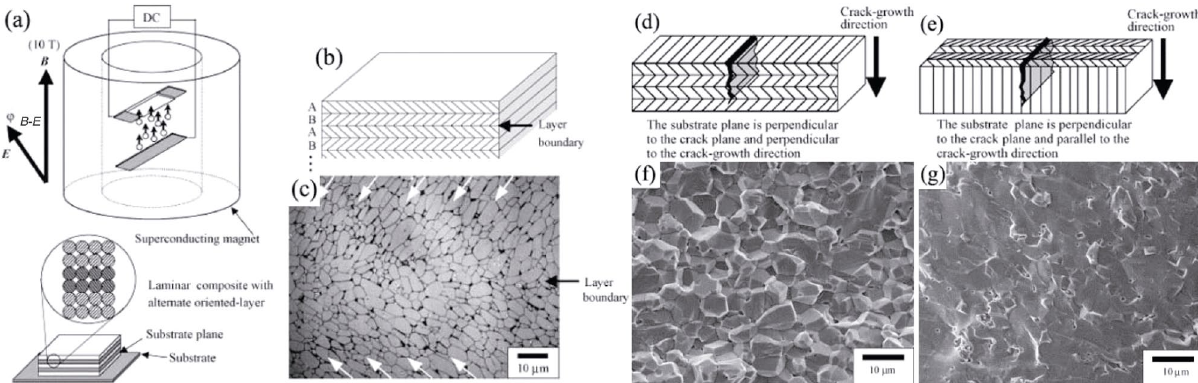
Fig. 23 Preparation and microstructures of multilayered α-Al 2 O 3 ceramics by electrophoretic deposition in a magnetic field: (a) schematic diagram of the experimental apparatus; (b, c) microstructure of a multilayered α-Al 2 O 3 specimen prepared by alternately changing Φ B-E = ±45°; (d, e) schematic diagrams of crack propagation perpendicular and parallel to the substrate, respectively; (f, g) fracture morphologies corresponding to (d) and (e), respectively. Reproduced with permission from Ref. [195], © Elsevier Ltd.